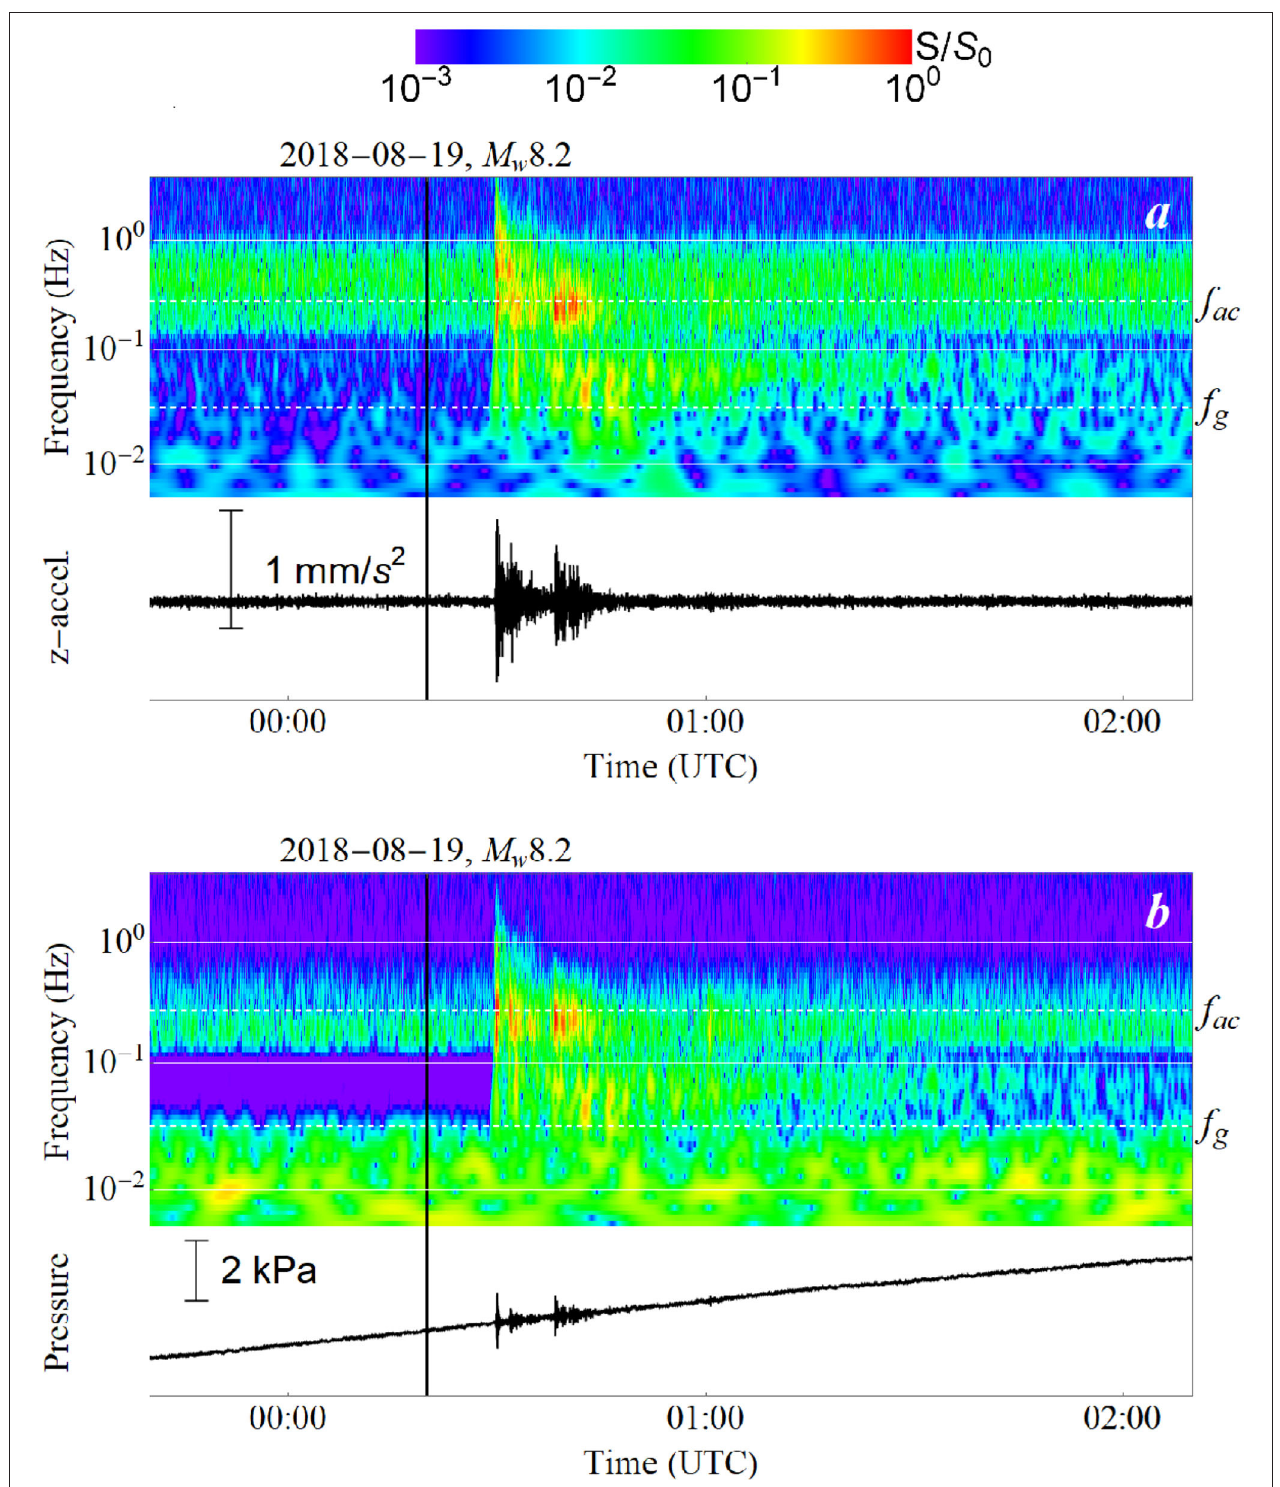
FIGURE 2 | The signals registered by the PG (a) and the z-accelerometer (b) of the Mra01 observatory during the earthquake, that occurred on 2018-08-19 in the region of the Fiji Islands ( M w = 8.2). The spectrograms are constructed with the aid of the Morlet wavelet transformation. Each spectrogram is normalized to its maximum value S 0 (the color scale is shown at the top of the figure). The white dotted lines in the spectrograms show the positions of the critical frequencies f g and f ac , determining the position of the frequency range of “forced oscillations.” The time moment corresponding to the beginning of the earthquake is indicated by black line.